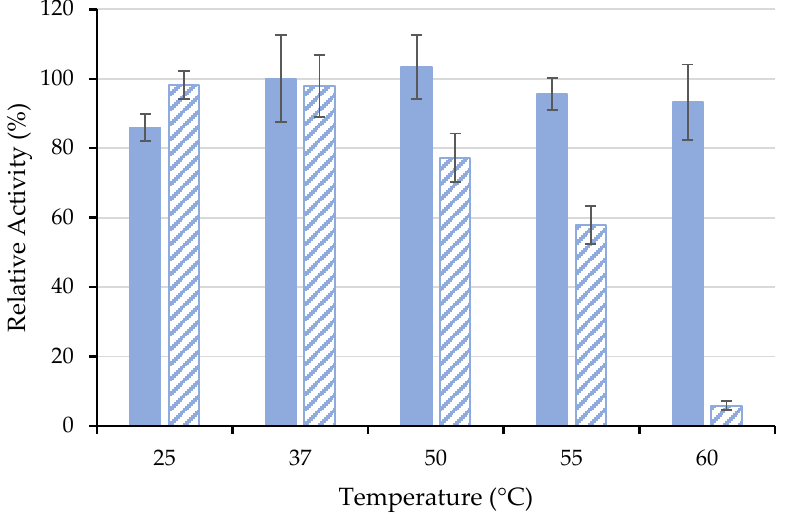
Figure 6. Thermal stability of 0.26 mg·mL −1 of ( ■ ) free and ( ) immobilized ASNase onto CX-4 by physical adsorption (pH 6.7, 49 min of contact time) at different temperatures for an incubation time of 60 min. Error bars represent the standard deviation.